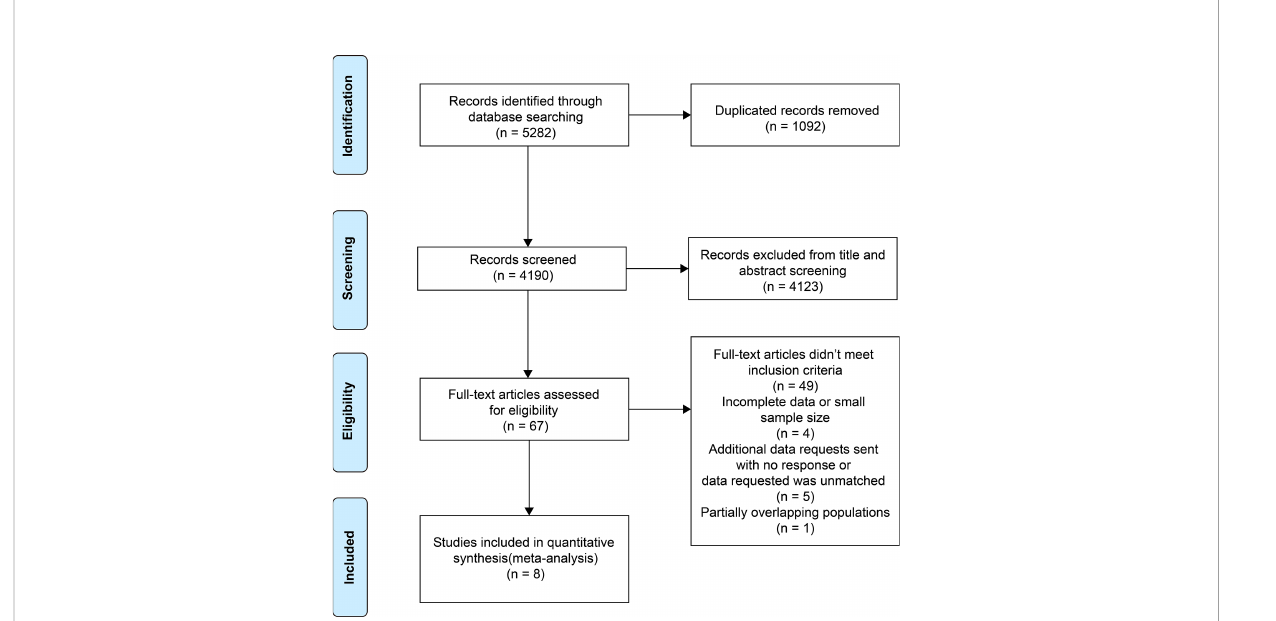
FIGURE 1 Preferred Reporting Items for Systematic Reviews and Meta-analysis (PRISMA) fl ow diagram of the study selection